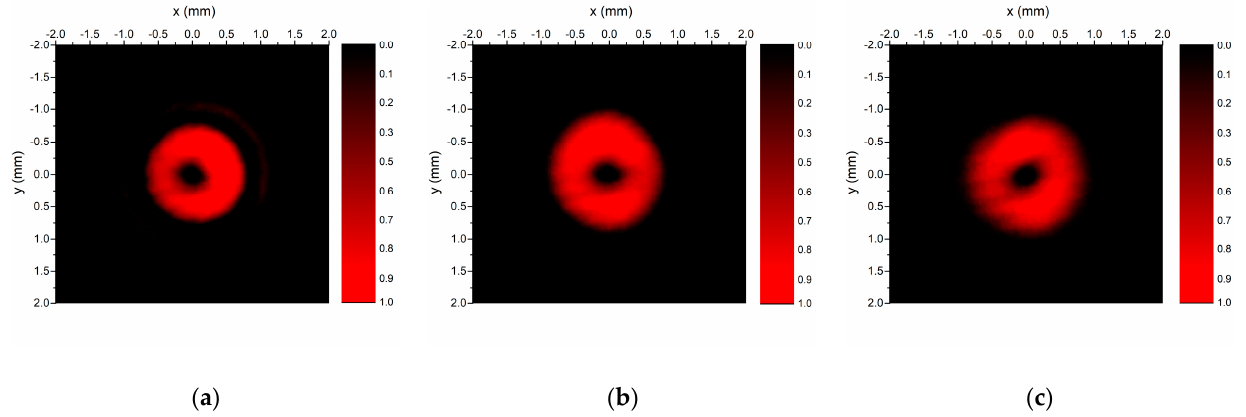
Figure 17. 2D plots of measured intensities of zero-order Bessel–Gauss beam generated with zero- order axicon recorded at ( a ) z = 30 cm, ( b ) z = 40 cm, ( c ) z = 50 cm. The cross-sections obtained from the 2D plots are represented in Figure 18. As in the of the ideal Bessel beam, |J 1 (k r x)| 2 .